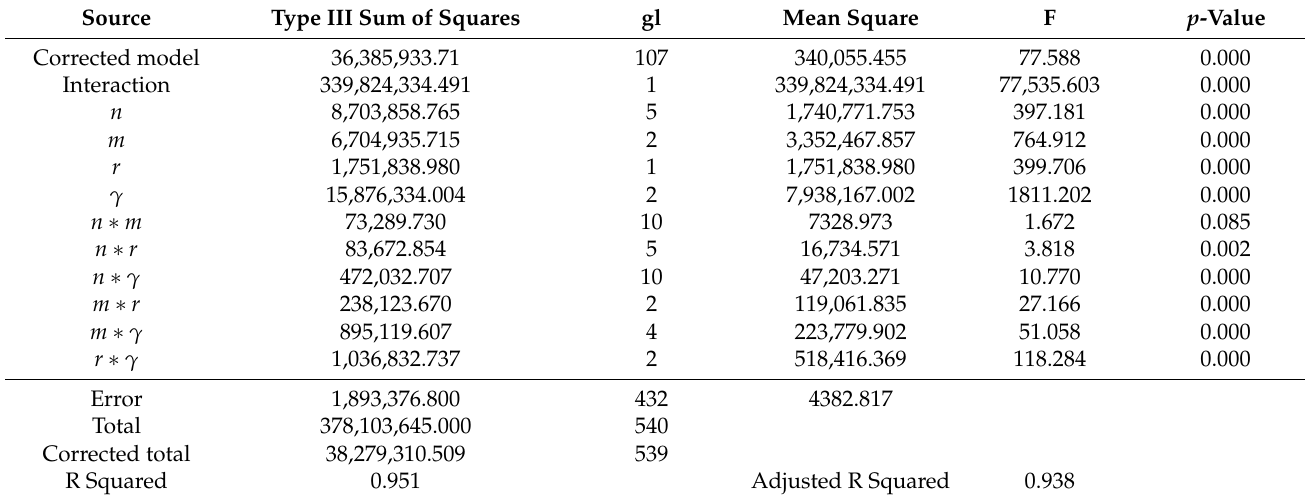
Table 14. Output from ANOVA using PR S